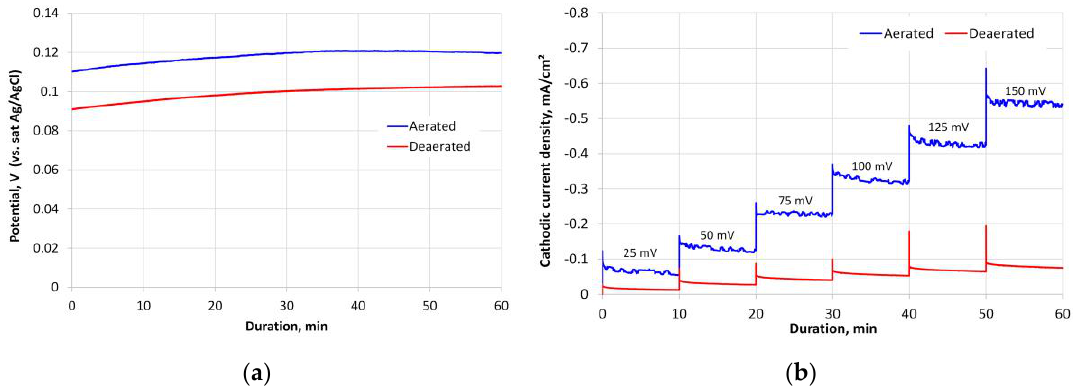
Figure 6. Curves of open circuit potential change over time ( a ) and chronoamperograms ( b ) of bare GF cathode in aerated and deaerated PBS. Each step in chronoamperograms corresponds to an increase of cathodic polarisation by 25 mV starting from open circuit potential (OCP).